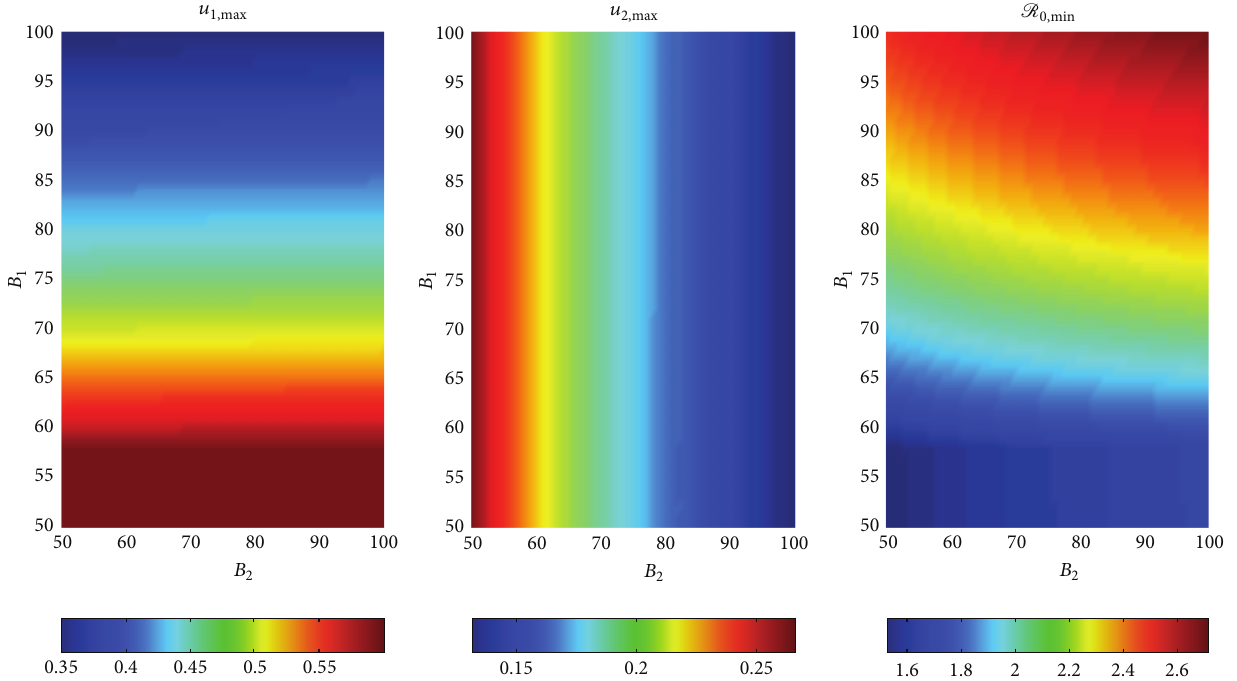
Figure 4: Maximum implementation of optimal control for different associated cost and minimum reduced level of R 0 due to the implementation of optimal